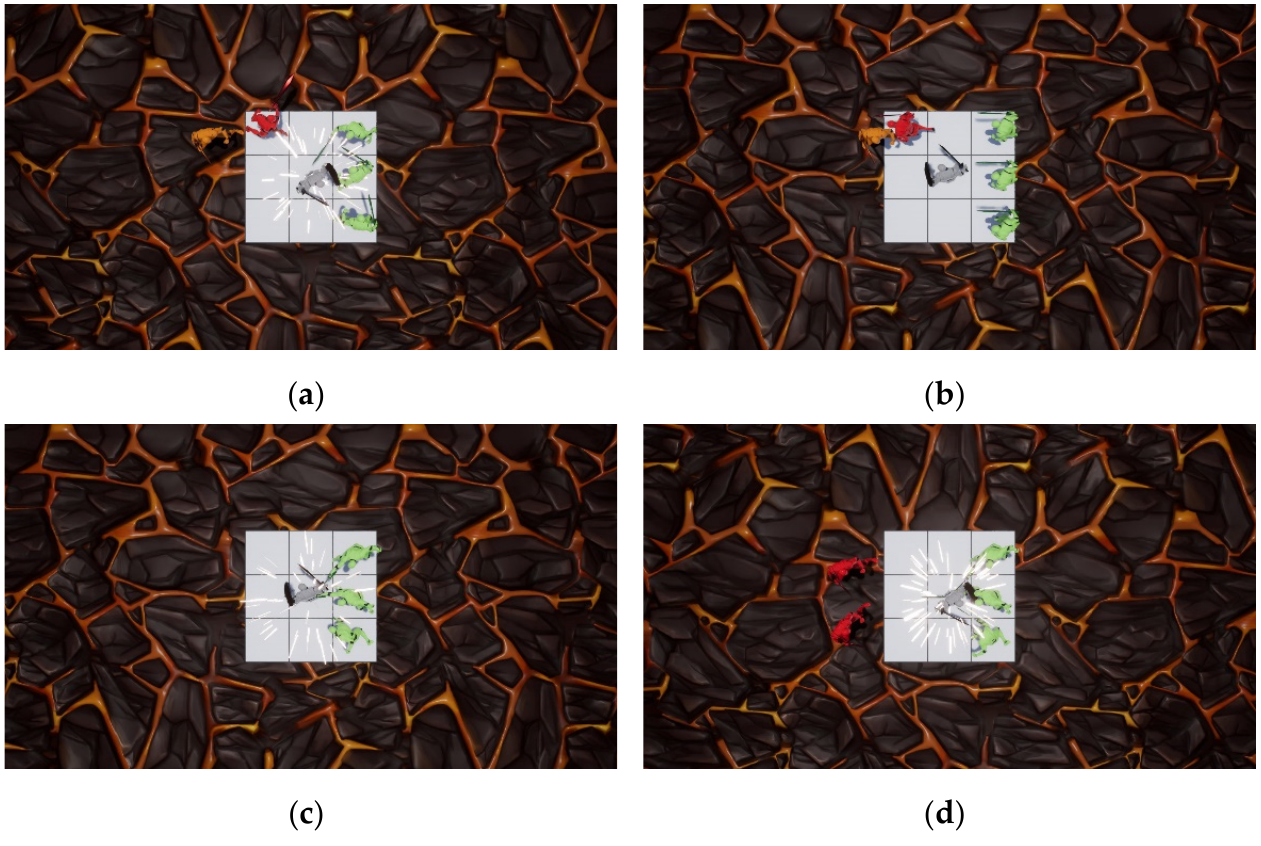
Figure 9. Allocation logic tests of BAI. ( a ) The first combat scene; ( b ) The second combat scene; ( c ) The third combat scene; ( d ) The fourth combat scene.